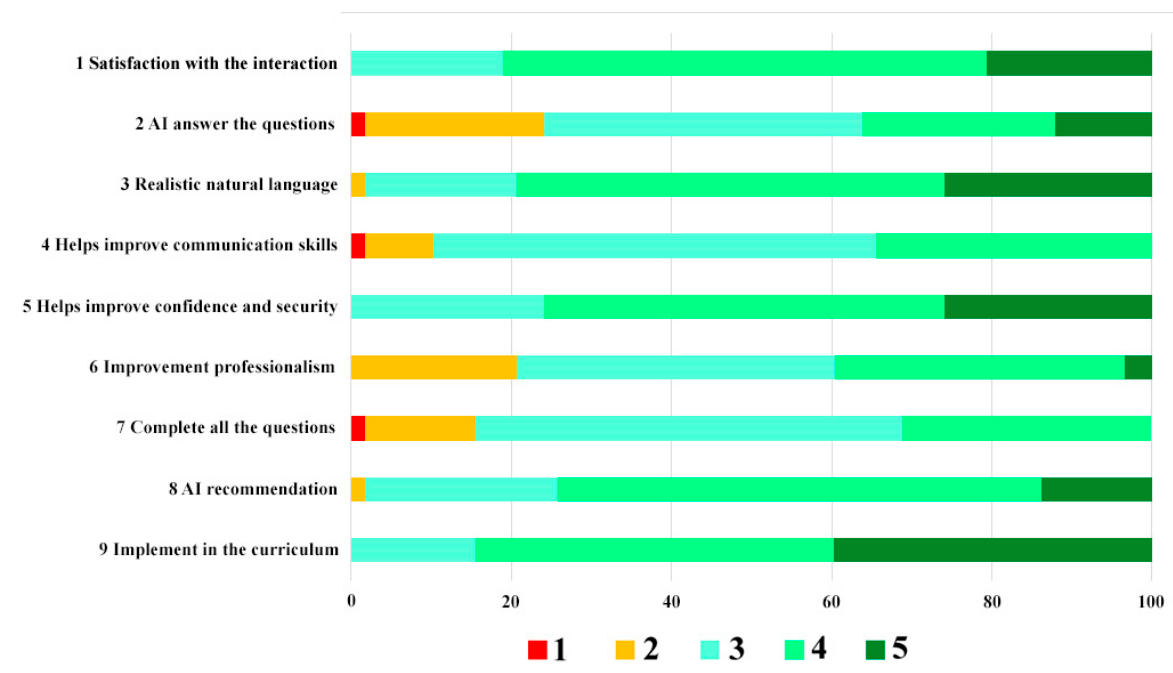
Figure 6. Distribution of responses per questionnaire item by fourth year dental students. 1-Strongly Disagree, 2-Disagree, 3-Neutral, 4-Agree, 5-Strongly Agree.